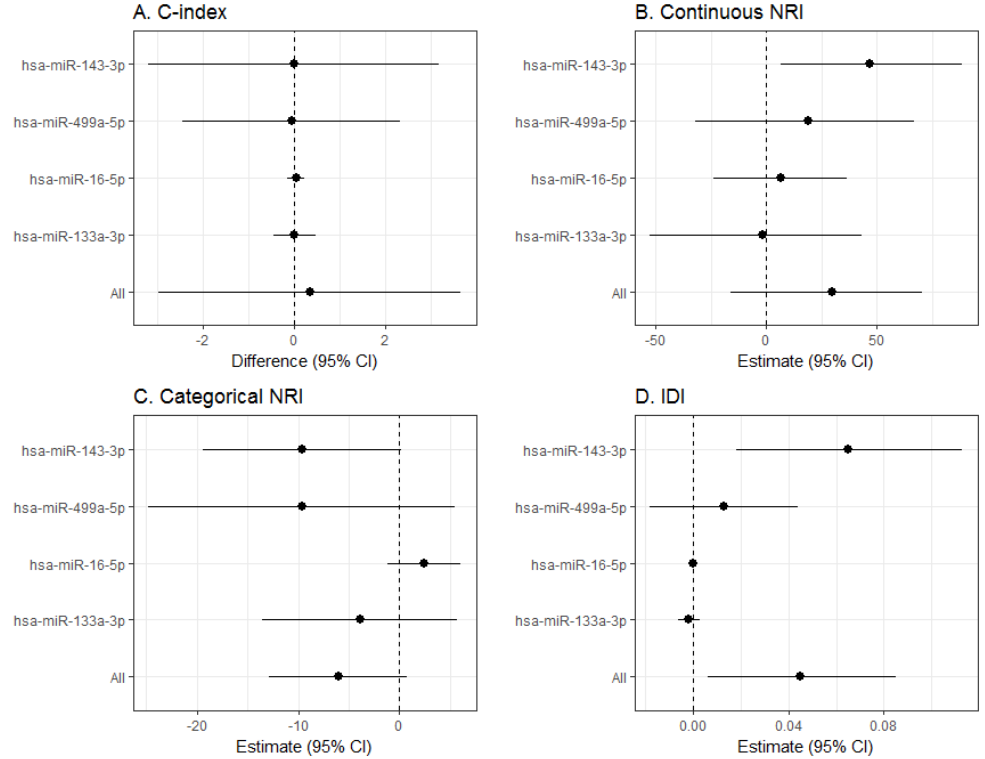
Figure 3. Predictive capacity of the most significant miRNAs identified in the case-control and the case-cohort studies. Change in discrimination and reclassification by including in the Framingham-REGICOR CAD risk function the 3 miRNAs most differentially expressed in the case-control study (hsa-miR-499a-5p, hsa-miR-16-5p and hsa-miR-133a-5p) and the miRNA differentially expressed in the case-cohort study (hsa-miR-143-3p). Discrimination was measured with the C-index ( A ), and reclassification with the net reclassification index (NRI) (continuous ( B ) and categorical ( C )) and with the integrated discrimination improvement (IDI) ( D ). CI: confidence interval.